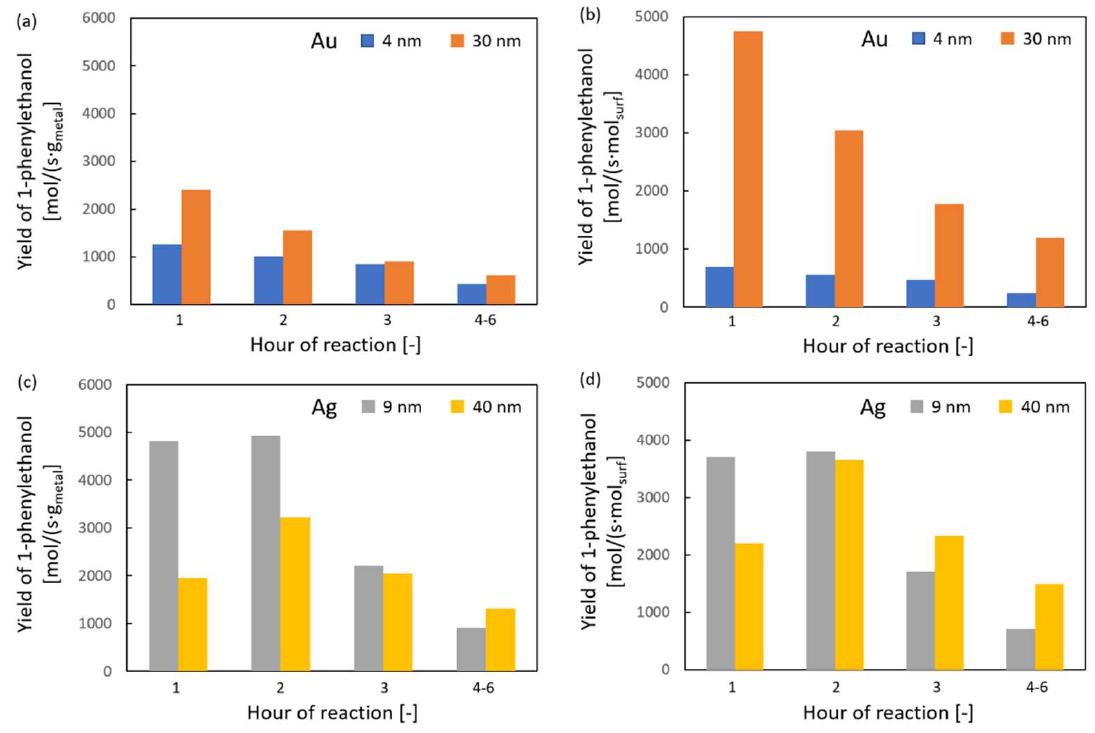
Figure 6. Yield of 1-phenylethanol during the course of the reaction referred to the mass of the active phase: ( a , c ), and to the surface number of moles of the active phase: ( b , d ).